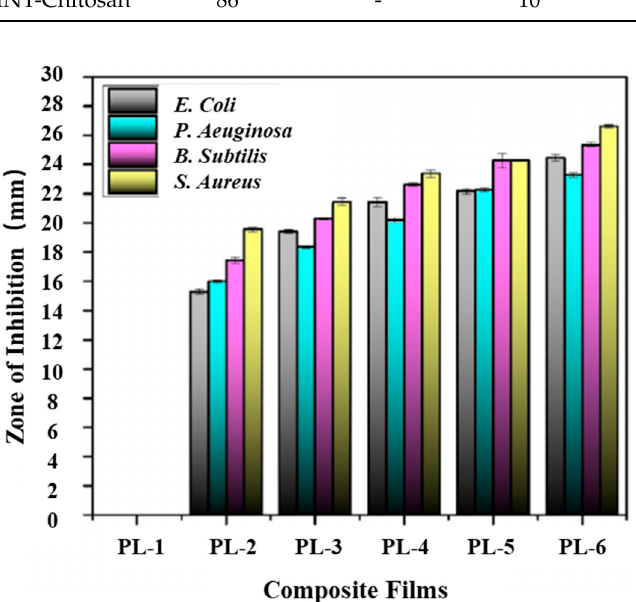
Figure 2. Antibacterial activity of NO- and curcumin-added various composite films. NO: neem oil Reprinted with permission from Ref. [61], published by John Wiley and Sons, 2021. Table 5. Names of samples in the literature.